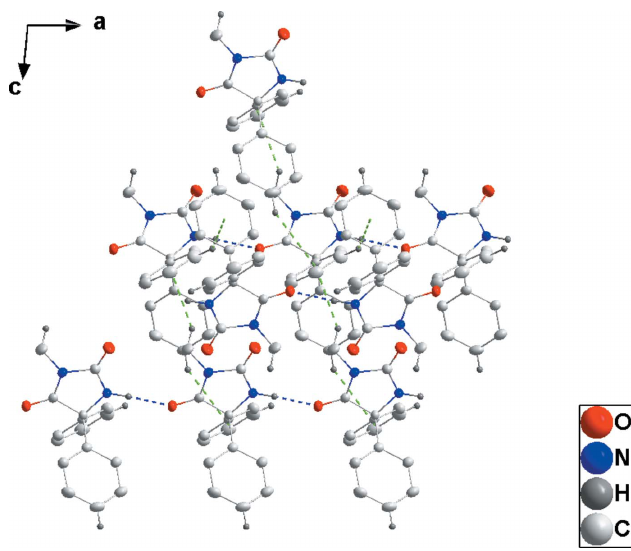
Figure 3 Packing of the title compound viewed along the b -axis direction, with N— H (cid:3)(cid:3)(cid:3) O hydrogen drawn as blue dashed lines.